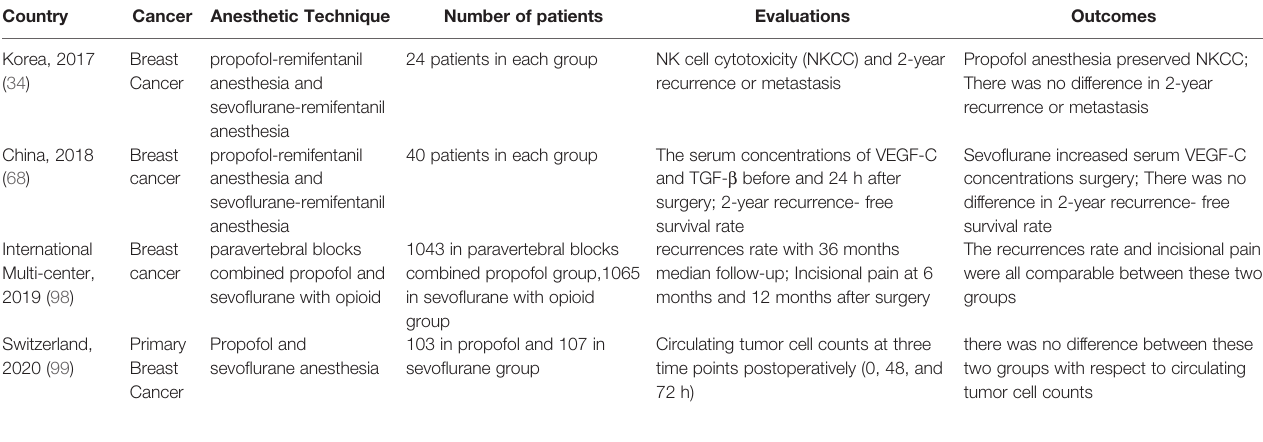
TABLE 2 | Randomized controlled trials comparing effects of propofol versus sevo fl urane on long-term prognosis of breast cancer. Country Cancer Anesthetic